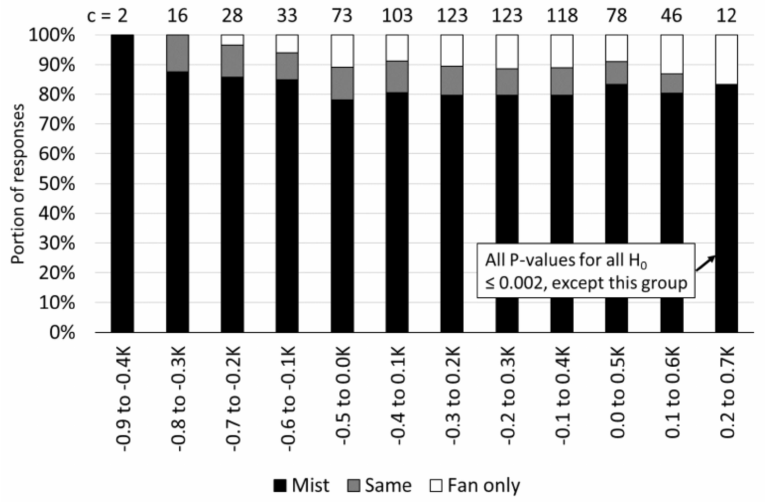
Figure 7. Proportion of responses on which air stream felt cooler in a rolling evaluation of 0.5 K bin width steps. Responses from the first experiment